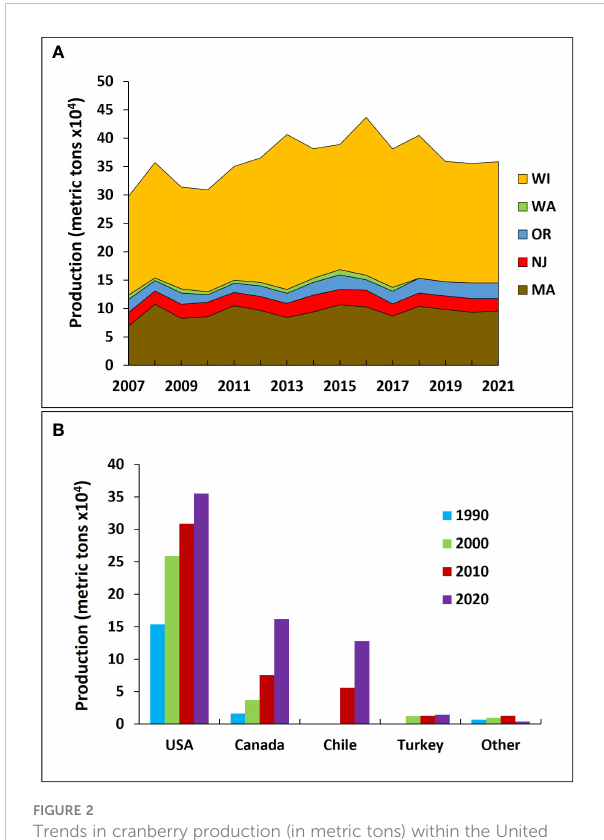
FIGURE 2 Trends in cranberry production (in metric tons) within the United States of America (USA) (A) and global cranberry production (B) . US states: WI, Wisconsin; MA, Massachusetts; NJ, New Jersey; OR, Oregon; WA, Washington. Data obtained from USDA NASS (2022) and FAOSTAT